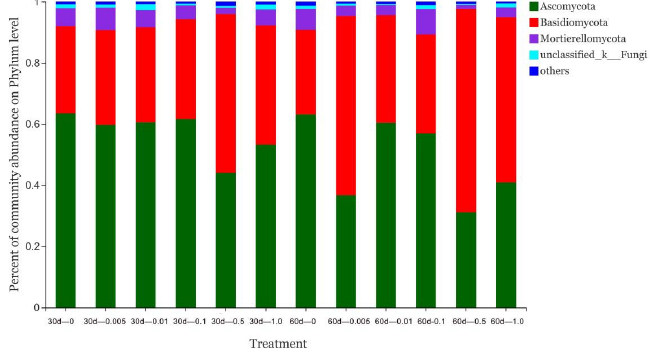
Figure 4. Effect of catechol on fungal community composition.